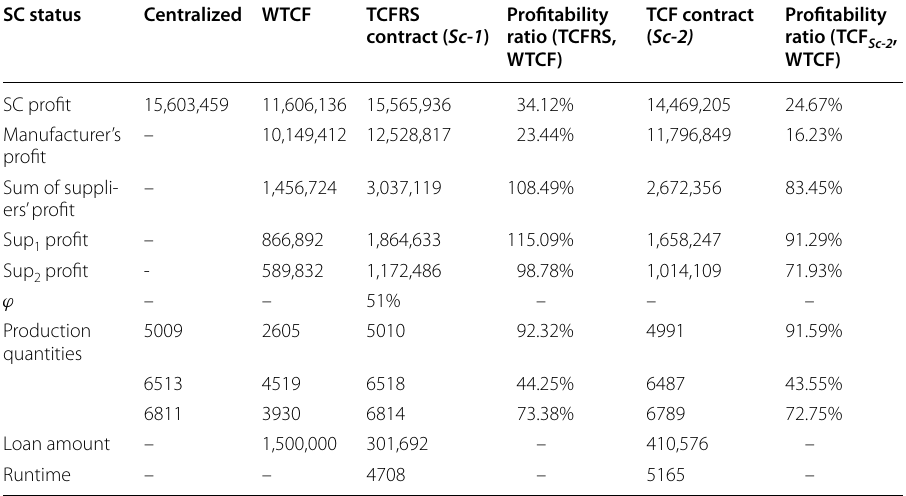
Table 9 The results of solving the proposed game for both scenarios with 2 suppliers and 3